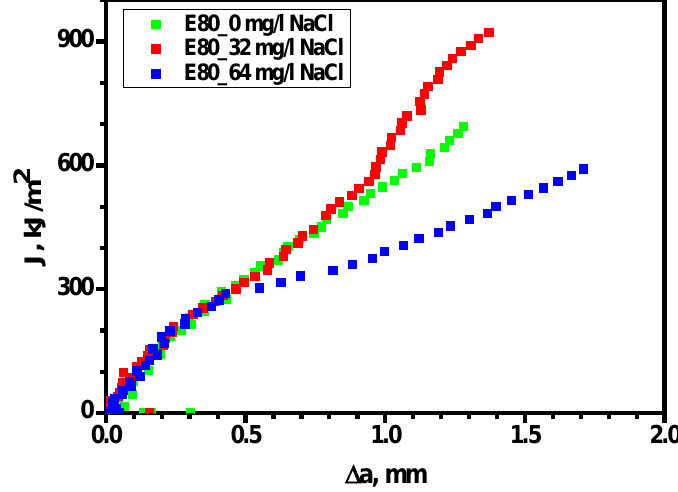
Figure 10. J - R curves obtained from MAS specimens in E80.